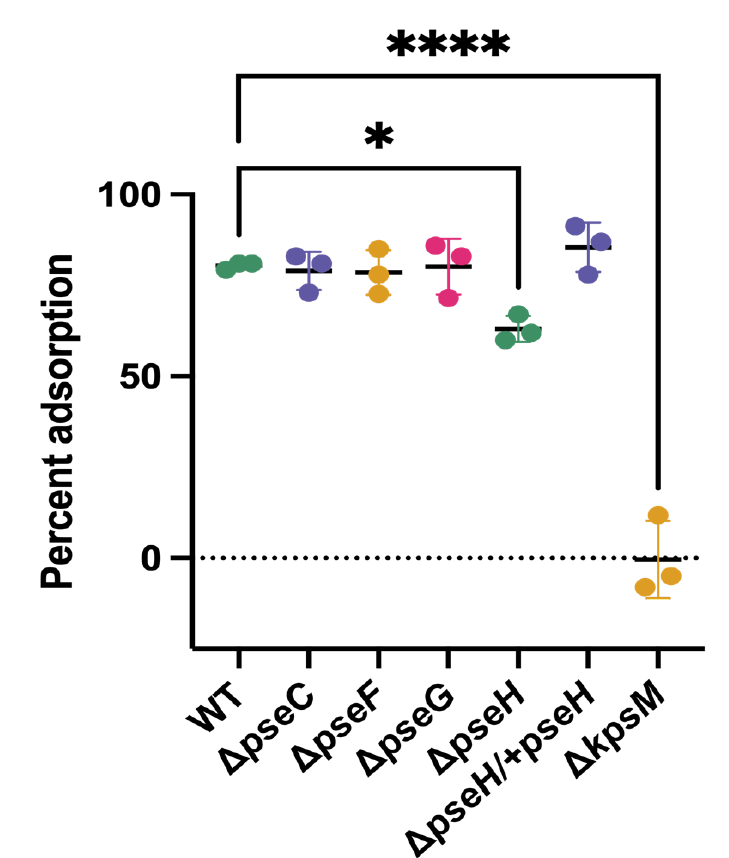
Figure 2. Percent phage NCTC 12673 adsorption to C. jejuni NCTC 11168 wild type and ∆ pseC , ∆ pseF ∆ pseG , ∆ pseH , ∆ pseH / + pseH , and ∆ kpsM mutants. Bars represent the mean of three biological replicates, and error bars represent standard deviations. Statistical significance as determined by one-way ANOVA is indicated by asterisks as follows: p < 0.05 (*) and p < 0.0001 (****). All other mutant strains were shown to have no significant difference from wild type.